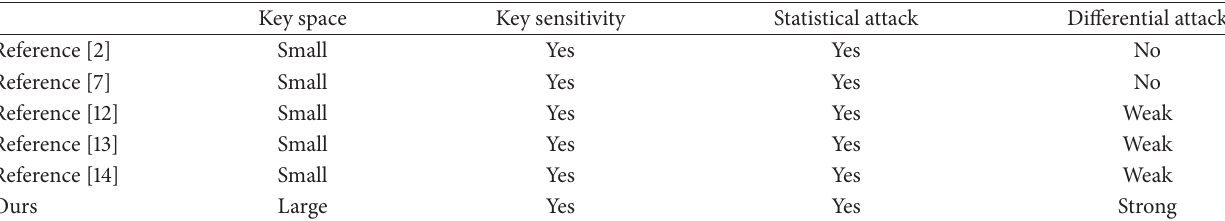
Table 7: Comparison with the simulation